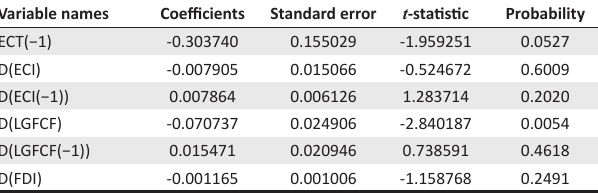
TABLE 2: Autoregressive distribution lag short run analysis results.